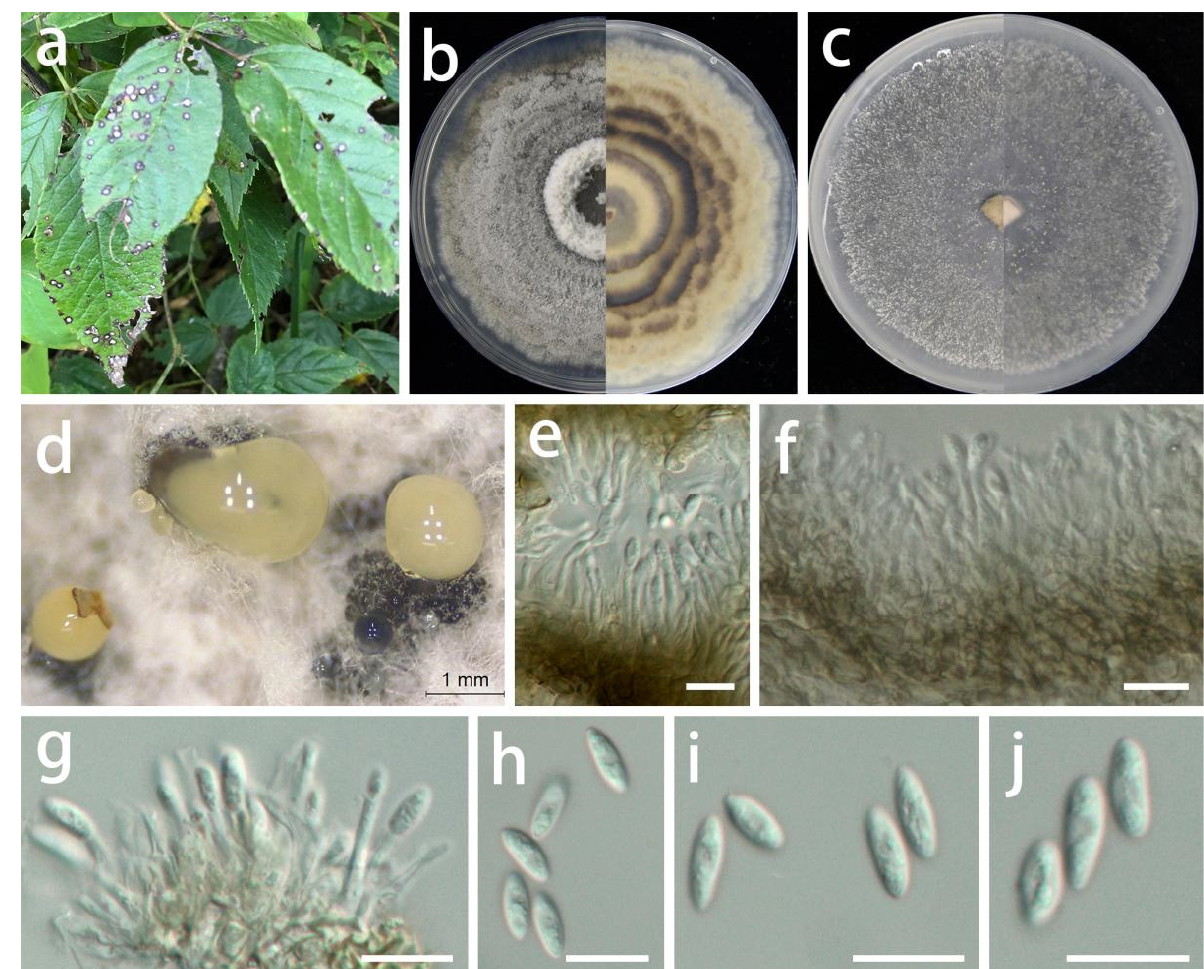
Figure 12. Gnomoniopsis rosae (GUCC 408.7). ( a ) Host: Rose sp. ( b ) Colonies on PDA after 2 wk at 25 °C (left: above, right: reverse). ( c ) Colony on OA after 2 wk at 25 °C (left: above, right: reverse). ( d ) Mass of conidia. ( e ) Conidiomata. ( f , g ) Conidiogenous cells. ( h – j ) Conidia. Scale bars: ( e – j ) = 10 μ m.